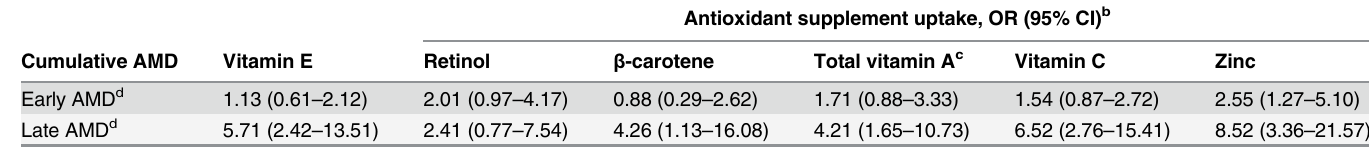
Table 2. Association between cumulative AMD and incident antioxidant supplement usage over 10 years a in the Blue Mountains Eye Study, pre- sented as adjusted odds ratio (OR) and 95% confidence intervals